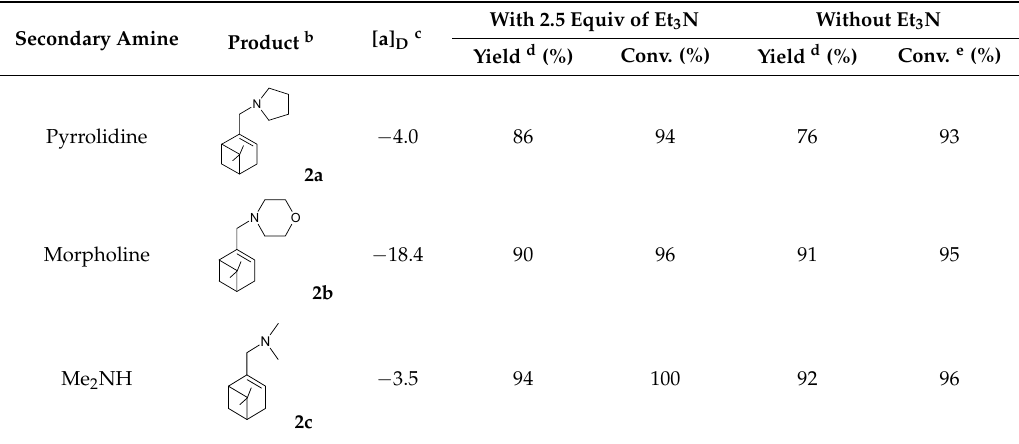
Figure 19. A general reaction amination of myrtenyl acetate ( 1 ) with different secondary amines (morpholine, pyrrolidine, and dimethylamine). Reproduced from [124] under the terms of the Creative Commons Licenses. Table 8. Catalytic amination of myrtenyl acetate a ( 1 ). Adapted from [124].